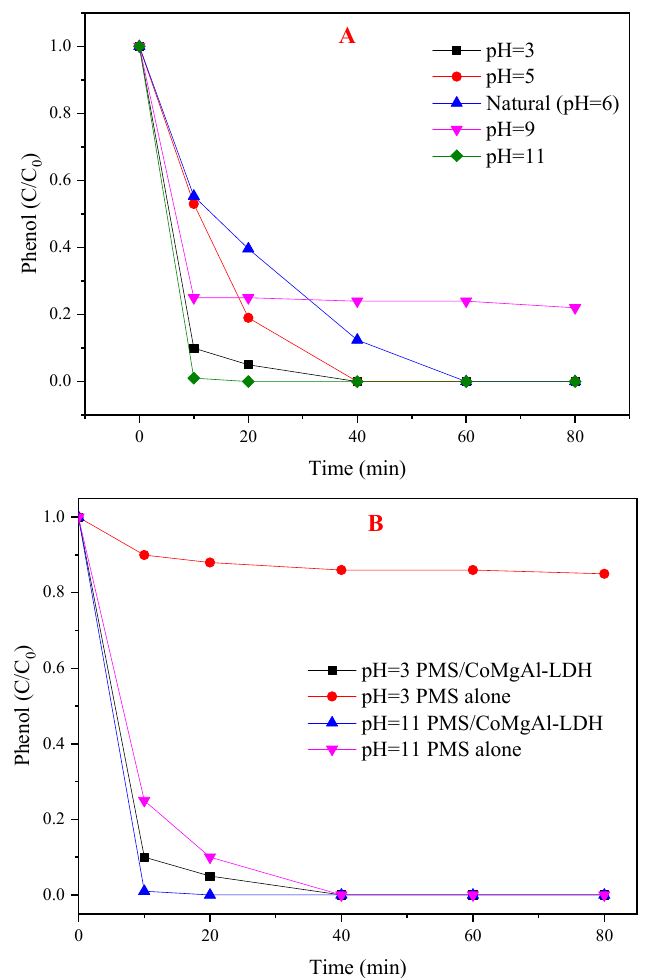
Figure 7. ( A ) Influence of different initial pHs of the PMS/CoMgAl-LDH system during the degradation of phenol; ( B ) comparison of absence and presence of CoMgAl-LDH with PMS removal of phenol.